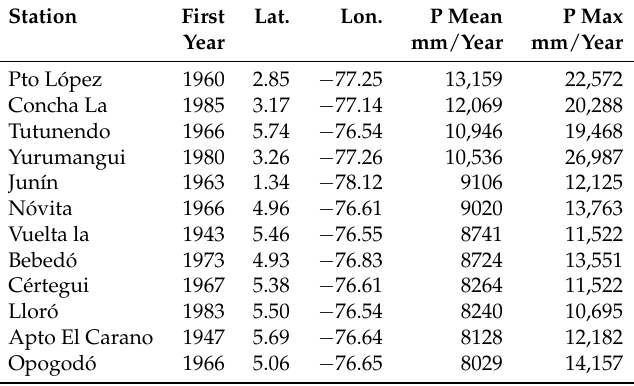
Table 1. Mean annual rainfall and maximum annual record values at diverse gauging stations in western Colombia. Station First